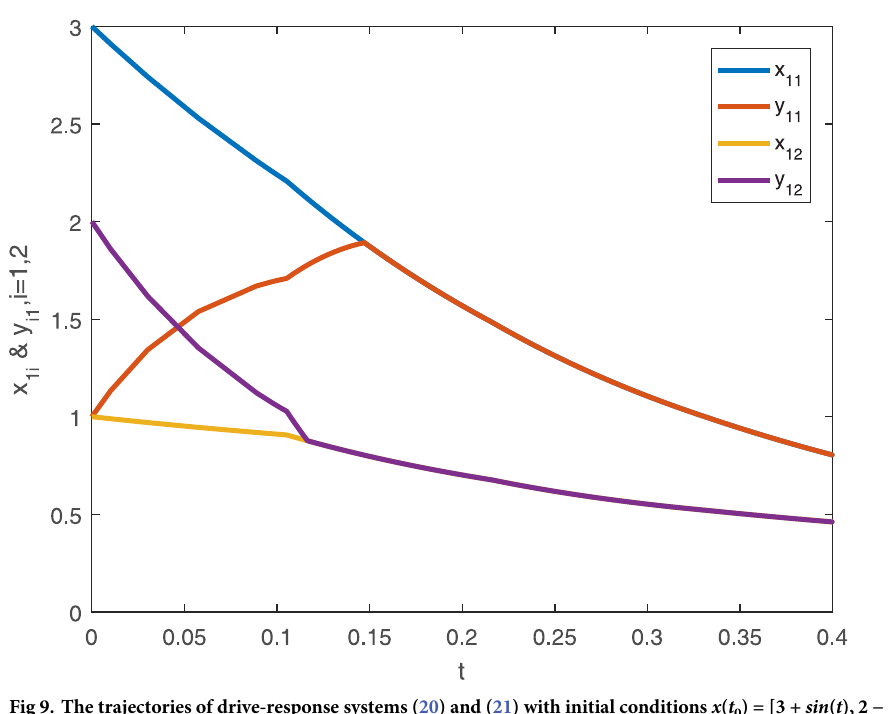
Fig 9. The trajectories of drive-response systems (20) and (21) with initial conditions x ( t 0 ) = [3 + sin ( t ),2 − cos ( t )] T , y ( t 0 ) = [1 − 2 sin ( t ),1 + cos ( t )] T under the controller (15).